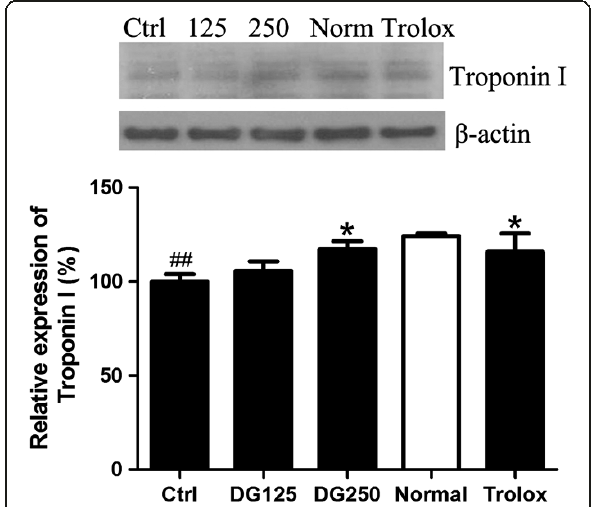
Figure 3 The effect of DG on Troponin I protein expression in H9c2 cells. After H9c2 cells were challenged with H/R in the presence or absence of DG (125 and 250 μ g/ml) or trolox (20 μ M), the expression of Troponin I was analyzed by Western blot and was normalized by β -actin. The figure is a representative of three individual experiments. The data were expressed as mean ± S.E.M. *p < 0.05 and **p < 0.01 indicated the groups with significant difference when compared to the control group; ### p < 0.001 when compared to the normoxic group.